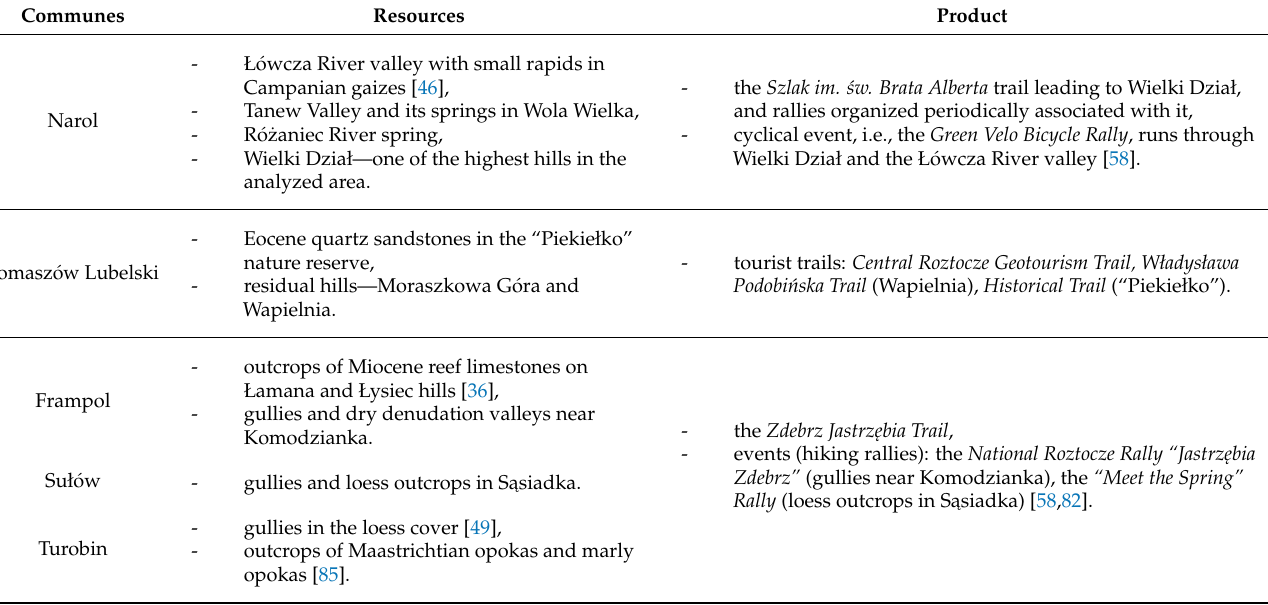
Table 10. Resources and products with low geotourism potential (TIGP = 0.001–0.060) in the